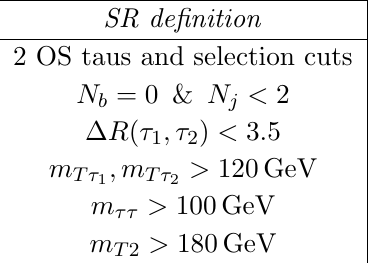
Table 2 . Summary of the cuts involved in the proposed signal region. The selection cuts were de(cid:12)ned in eq.